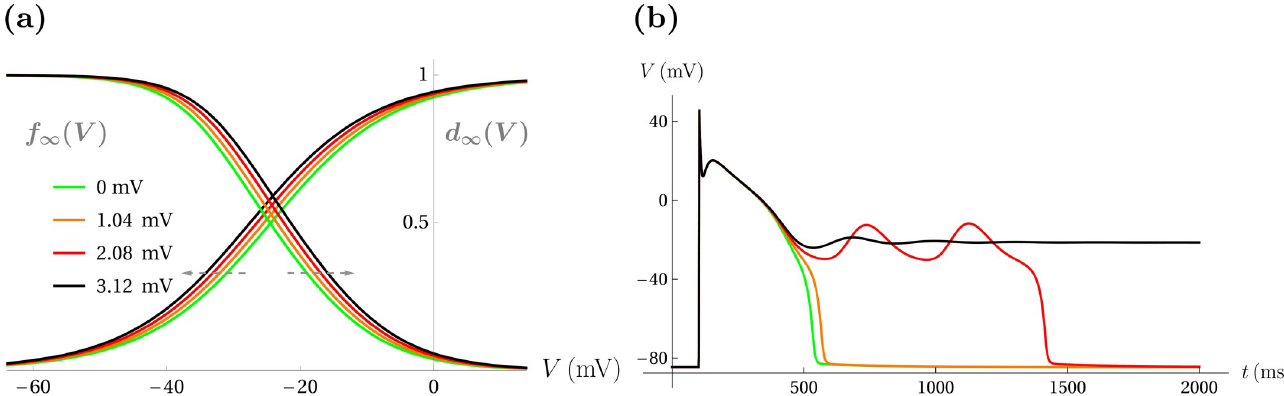
Fig 3. A sufficiently large symmetric broadening of the window region can lead to EADs and repolarization failure in response to a stimulus pulse. ( a ) An equally-spaced sequence of three color-coded symmetric window broadening translations in d 1 ( V ) and f 1 ( V ) (orange, red, and black curves) are shown alongside the default curves d 1 ( V ) and f 1 ( V ) (green). The magnitudes of each of the simultaneous changes to both Δ V 1/2 ( d 1 ) and Δ V 1/2 ( f 1 ) are shown in the legend. ( b ) The color-matched model responses correspond to the manipulations in panel (a).